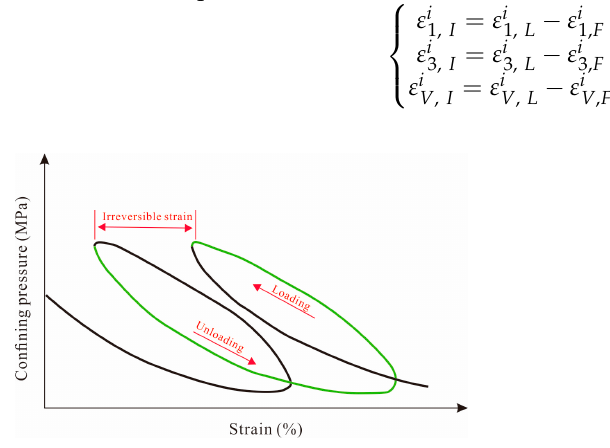
Figure 6. Irreversible strain in a single cycle.